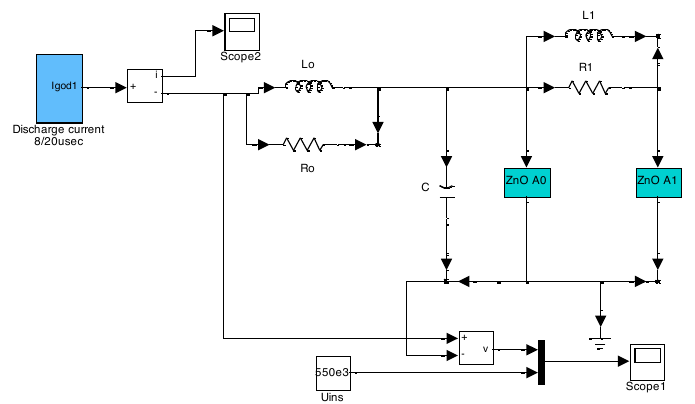
Fig. 4. The simulation model for the performance analysis of ZnO surge arresters